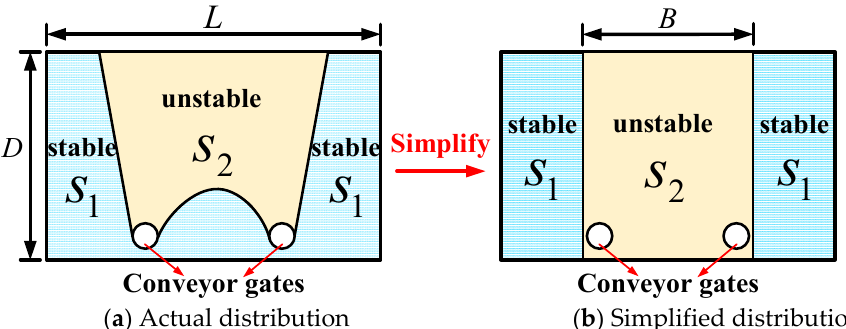
Figure 2. Distribution characteristics of support pressure.